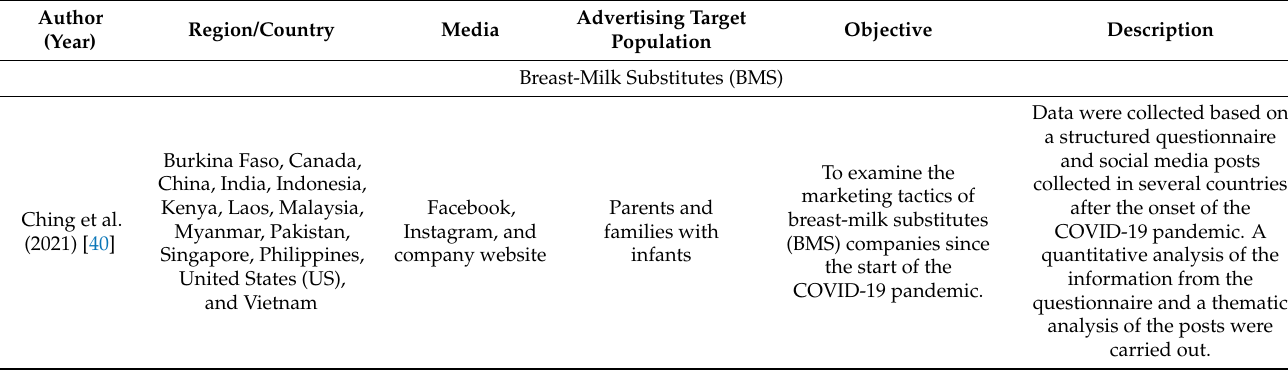
Figure 4. Key characteristics of the included studies on methodologies for monitoring BMS and FBHFSS digital marketing to ICA [27,30,34,36,40,44,45,48,50]. BMS: Breastmilk substitutes; the Code: International Code of Marketing of Breast-milk Substitutes; NPM: Nutritional Profile Model; PAHO: Pan-American Health Organization, UK: United Kingdom; WHO: World Health Organization; BMS: breast-milk substitutes; FBHFSS: foods and beverages high in saturated fat, salt, and/or free sugars; ICA: infants, children, and adolescents; IBFAN: The International Baby Food Action Network; ICDC: International Code Documentation Centre. Table 2. Summary of the included sources in the scoping review ( n = 28).